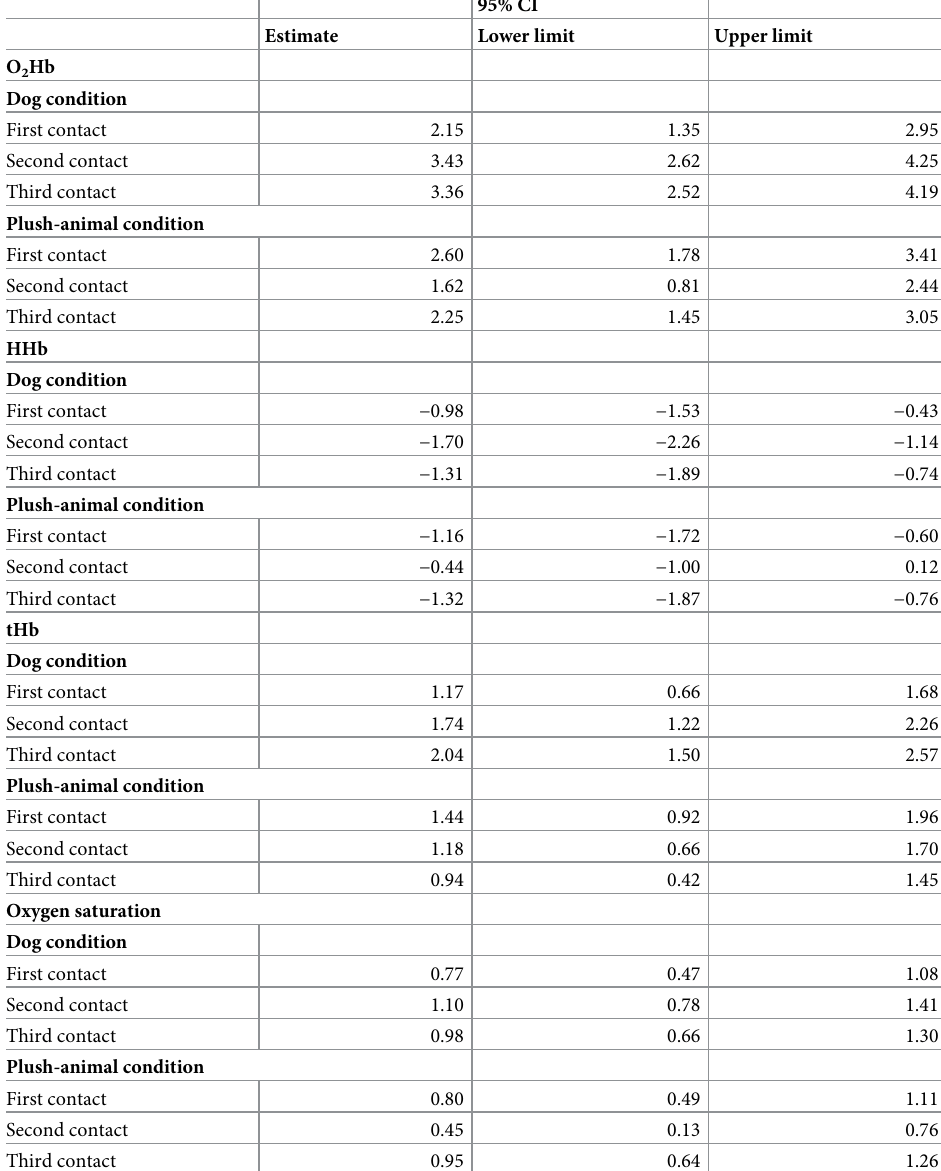
Table 1. Marginal effects of condition by number of